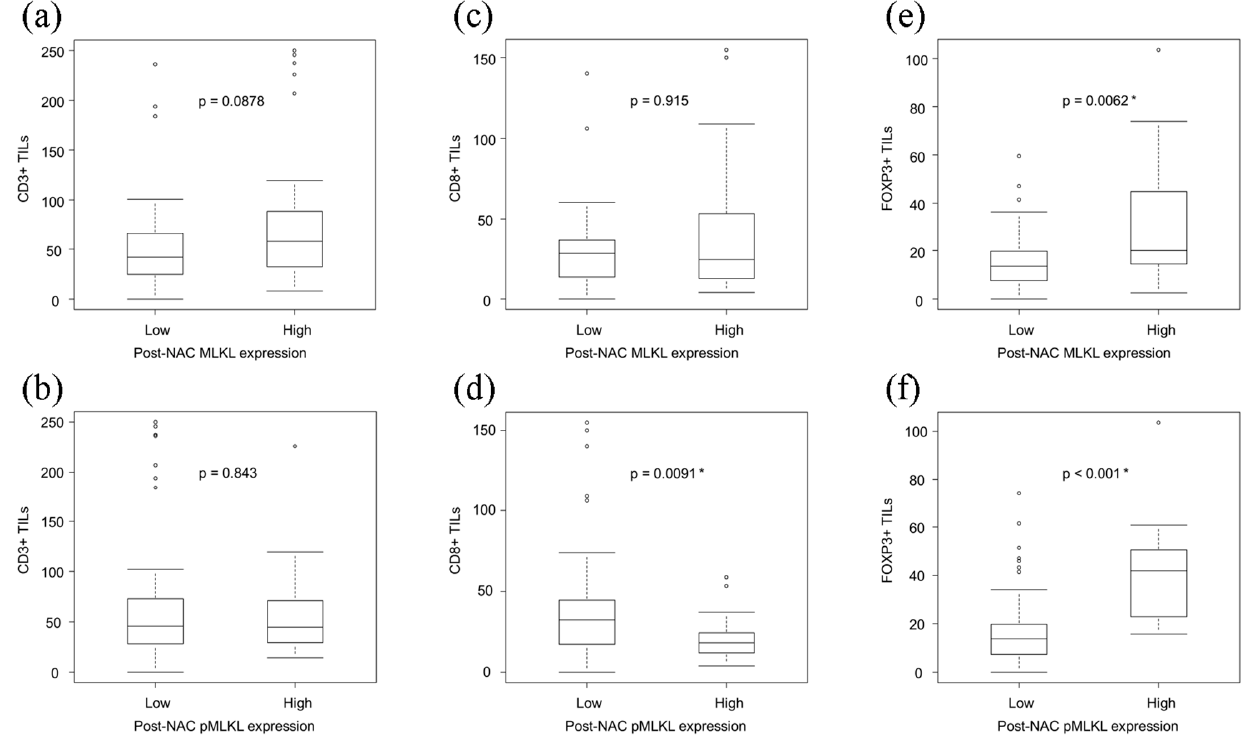
Figure 4. Representative illustrations of tumor-infiltrating lymphocytes (TILs). ( a ) Low CD3+ TILs, and ( b ) high CD3+ TILs. ( c ) Low CD8+ TILs, and ( d ) high CD8+ TILs. ( e ) Low FOXP3+ TILs, and ( f ) high FOXP3+ TILs.